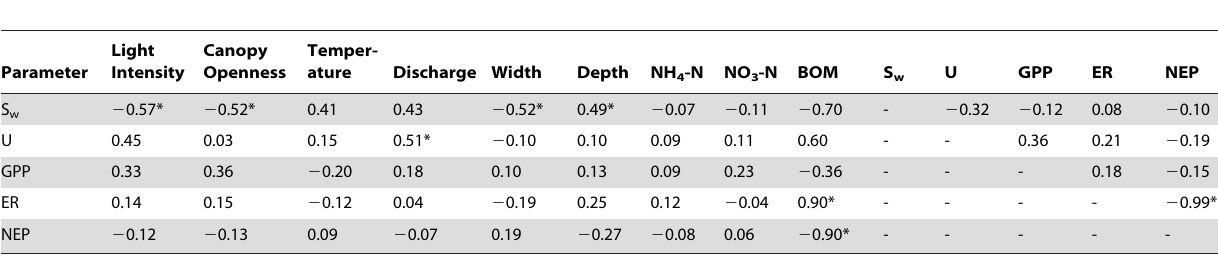
Table 3. Relationships between variables in this study.